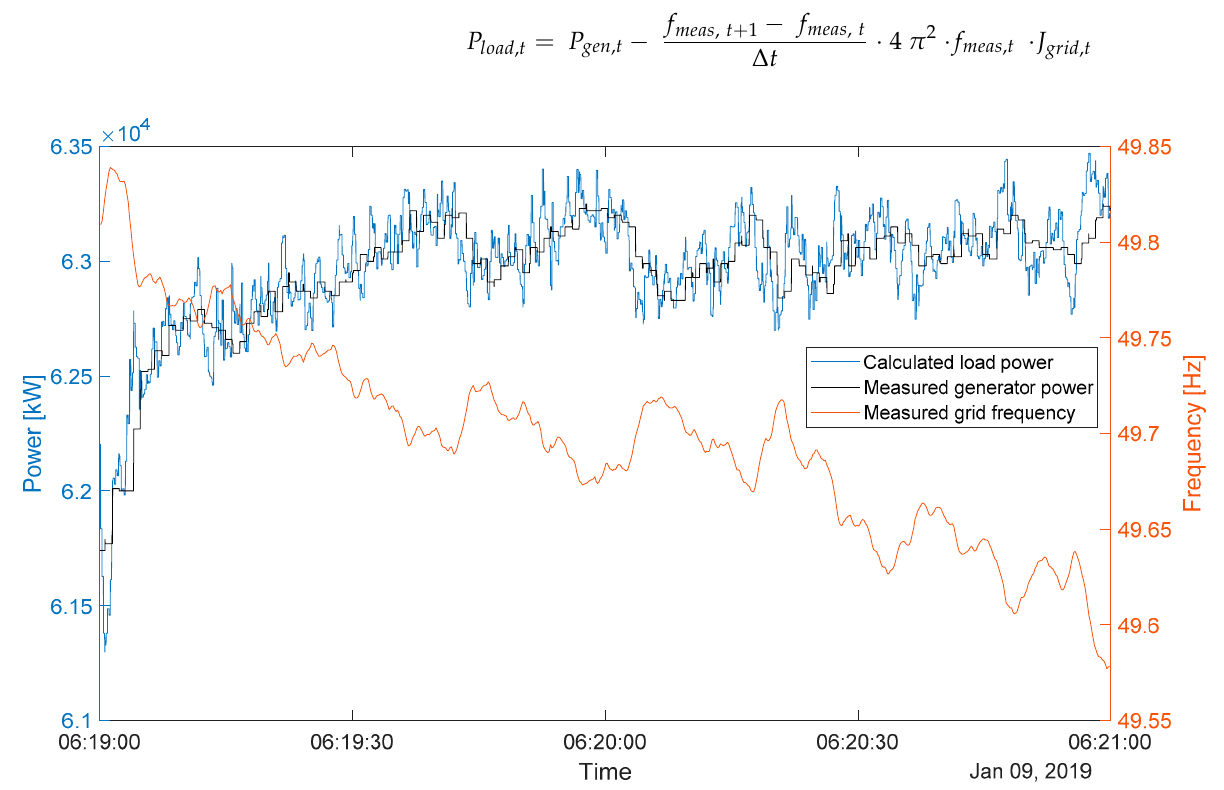
Figure 7. Example of the load power, calculated with the measured generator power and the grid frequency measured at WETI.